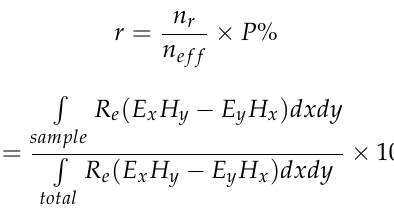
Table 1. Refractive index of fused silica for different operating wavelengths.